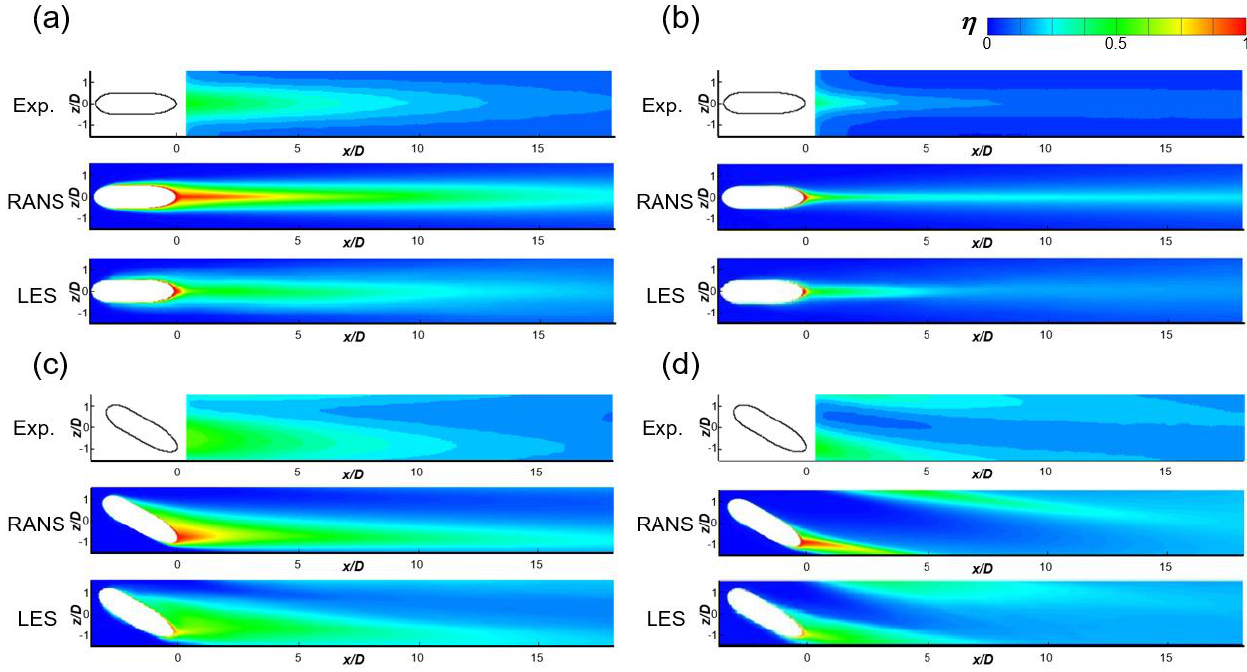
Figure 7. Local adiabatic film-cooling effectiveness distributions with the forward expansion hole [72]: ( a ) simple angle, M = 0.5; ( b ) simple angle, M = 1.0; ( c ) compound angle, M = 0.5; and ( d ) compound angle, M = 1.0.